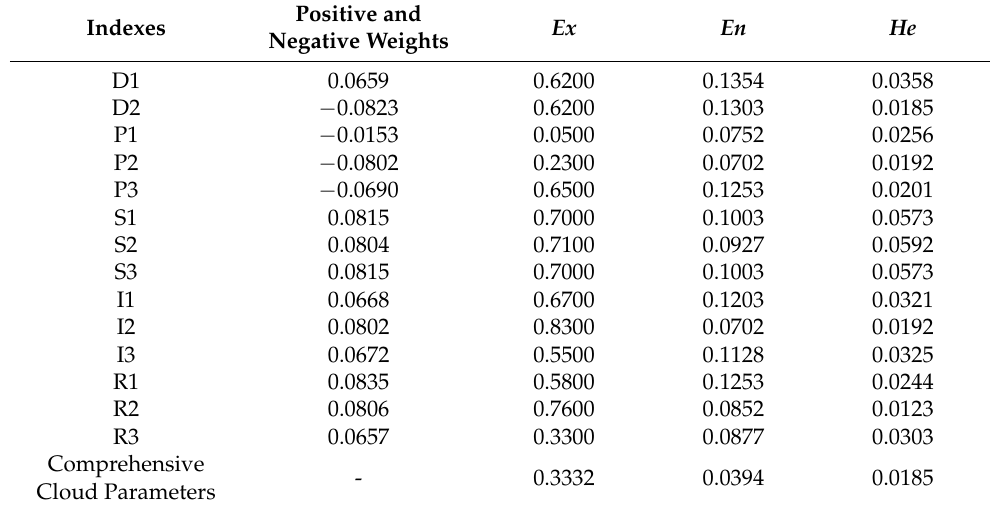
Table 5. Index weight and cloud parameters in the long-term operation